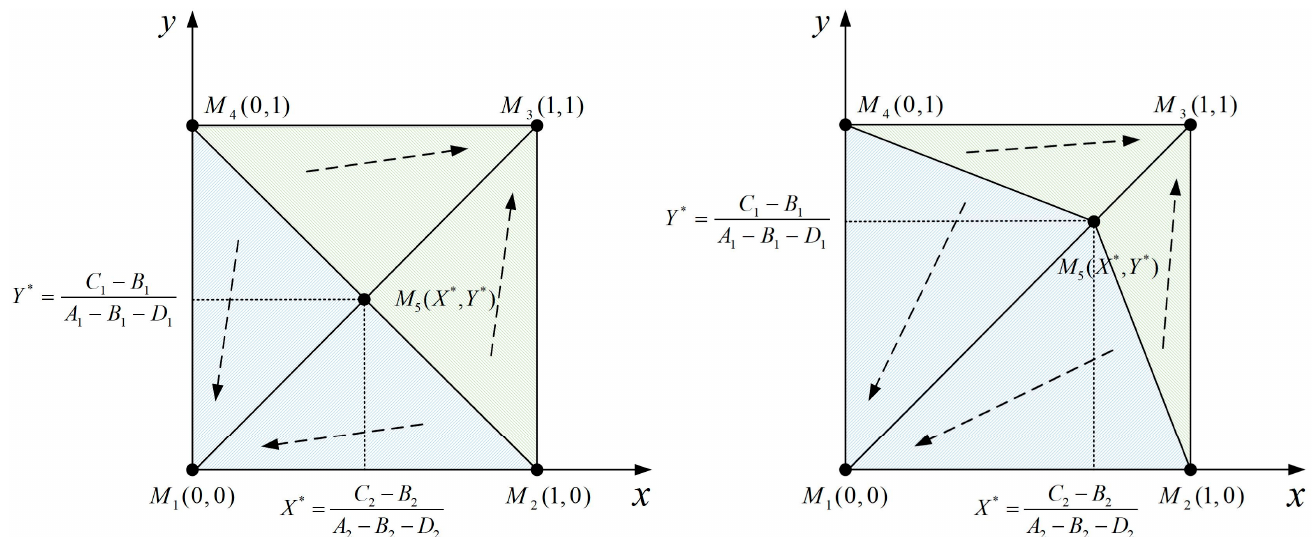
Figure 5. Phase diagram of the evolution of upstream and downstream governments’ decision-making behavior (with the non-supervision of the central government).